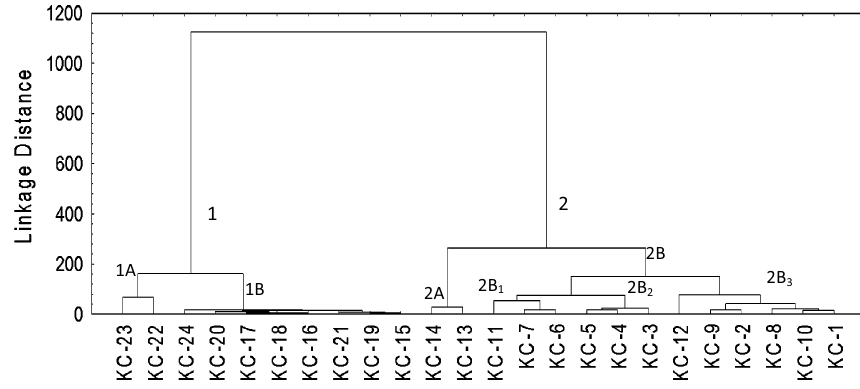
Fig. 4 Dendrogram derived from Ward’s method of 24 sites based on physical, chemical and microbiological quality of Korangi creek